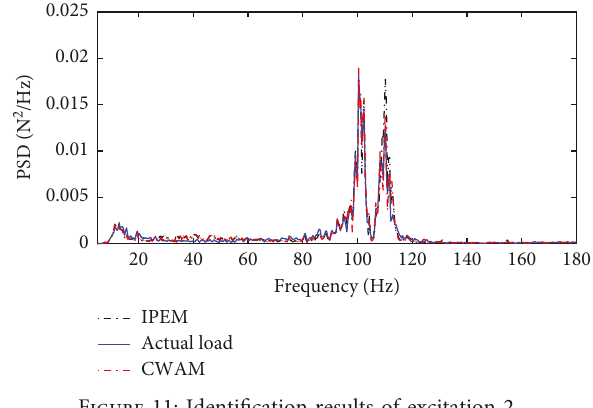
Figure 11: Identification results of excitation 2.